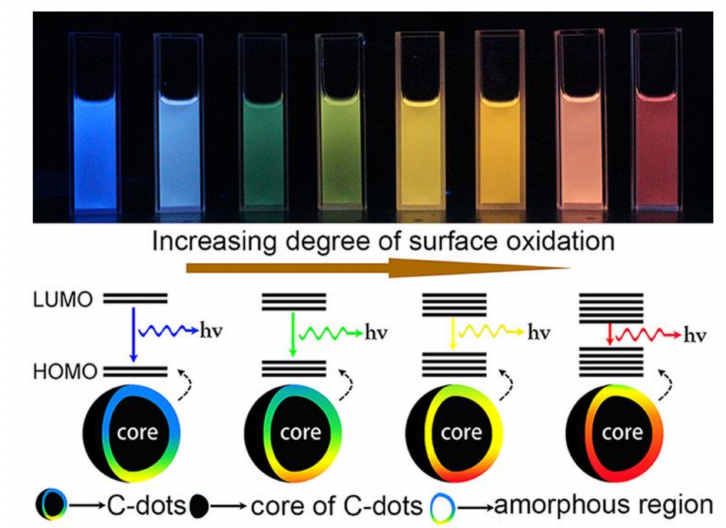
Figure 9. Mechanism of the tunable fluorescent luminescence of C-dots with di ff erent degrees of surface oxidation [118].